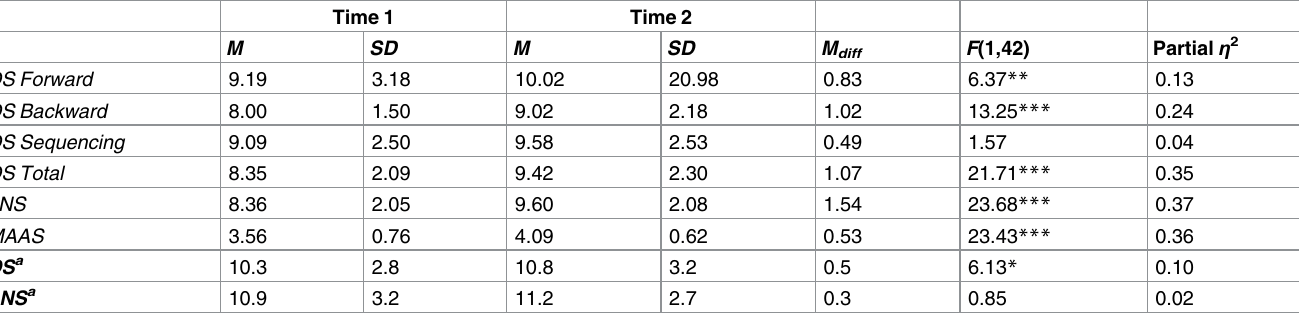
Table 2. Working memory function before and after yoga intervention.